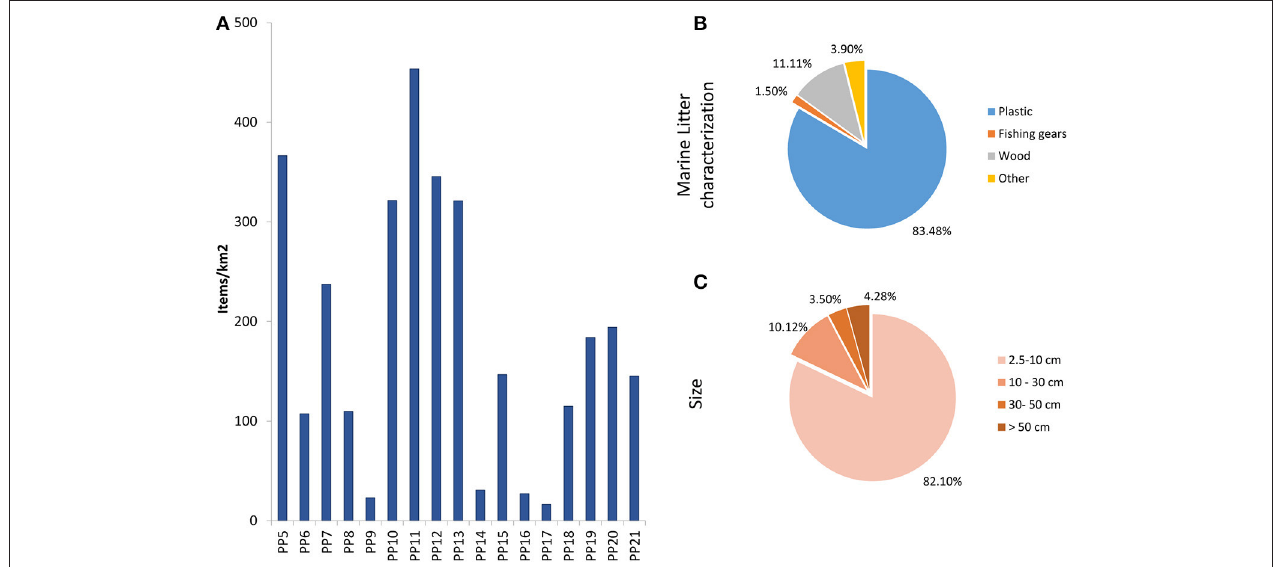
FIGURE 3 | Macrolitter abundance and characterization in the Pelagos Sanctuary. (A) macrolitter abundance in the different samplig sites (items/Km 2 ); (B) macrolitter characterization; (C) macrolitter size.